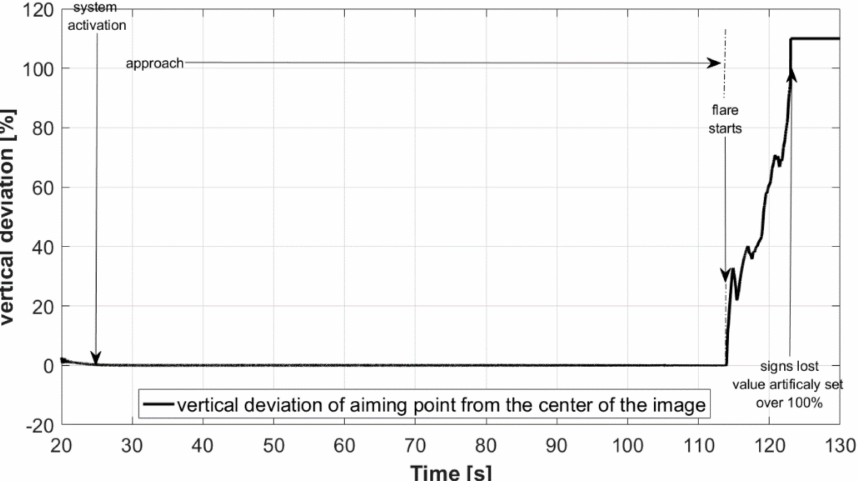
Figure 19. Vertical deviation of the position of the aiming point from the center of the picture given in the range < − 100; 100> percent of image height in pixels.